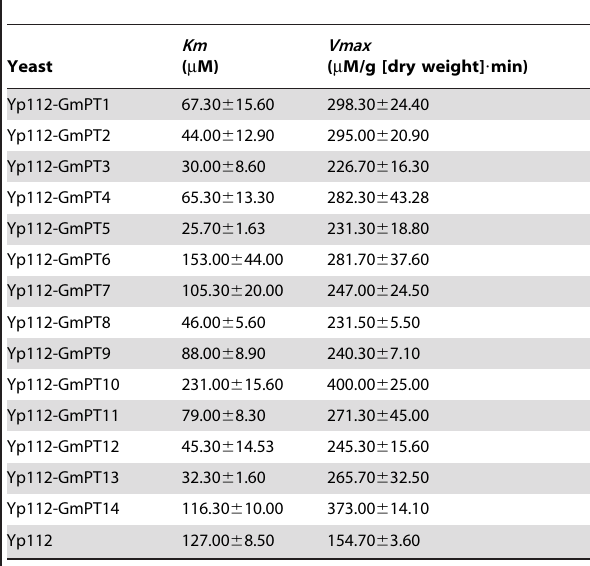
Table 2. Kinetic parameter estimates of GmPTs-mediated inorganic phosphate (Pi)